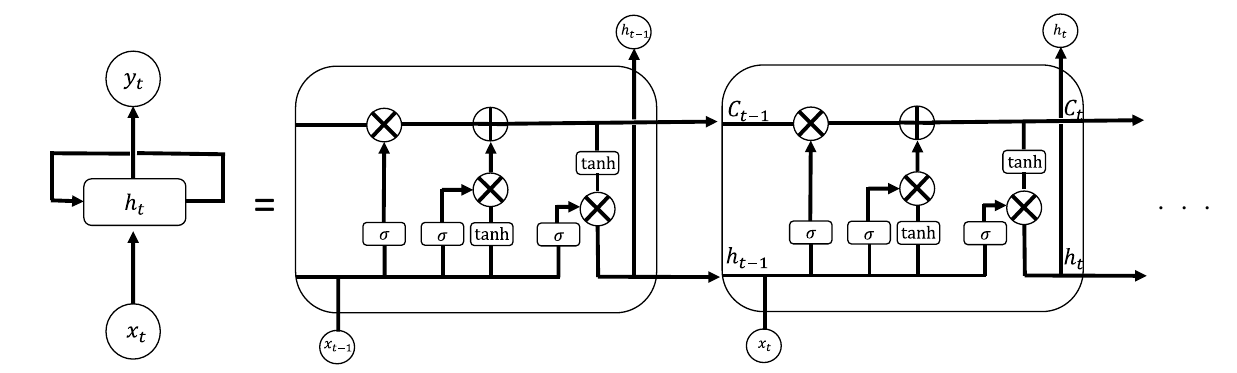
Figure 1. Structure of long short-term memory neural network.